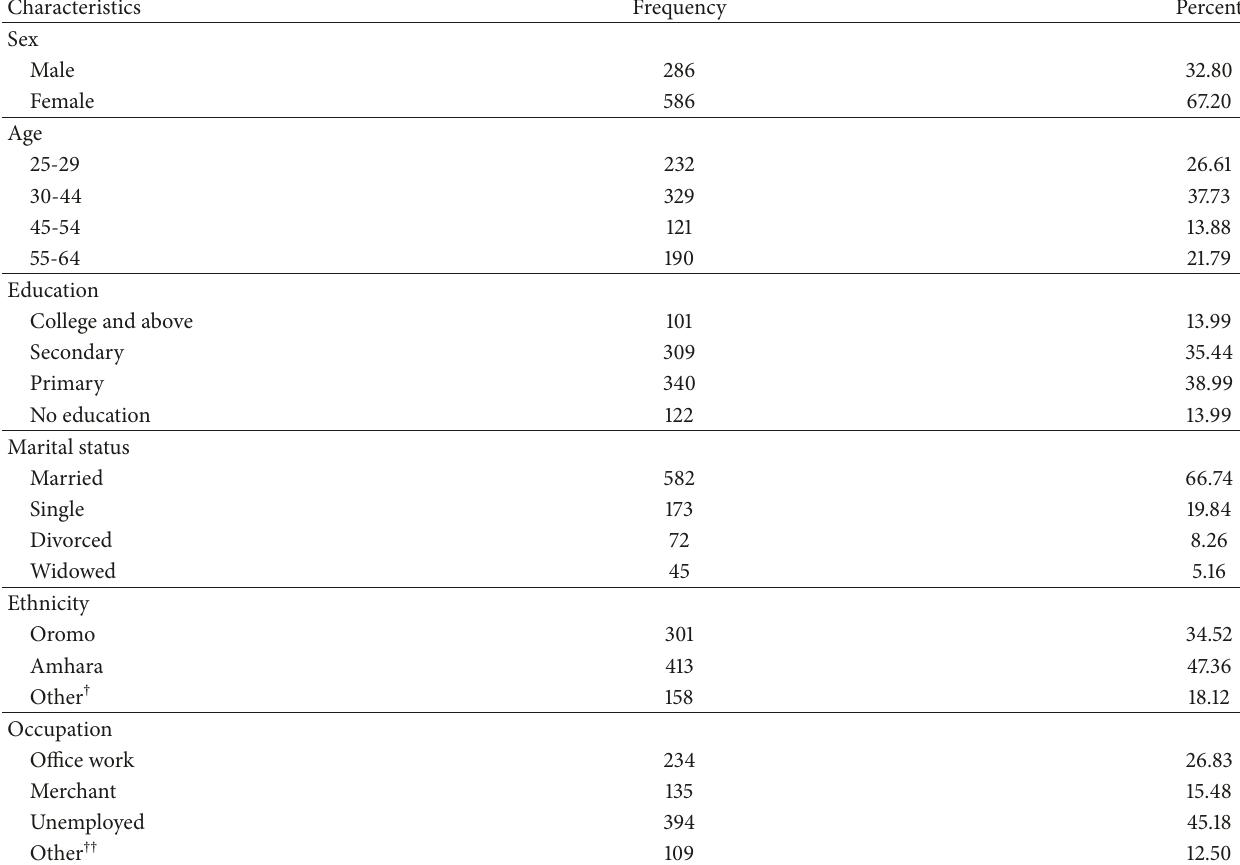
Table 1: Sociodemographic characteristics of adults in Dire Dawa city,